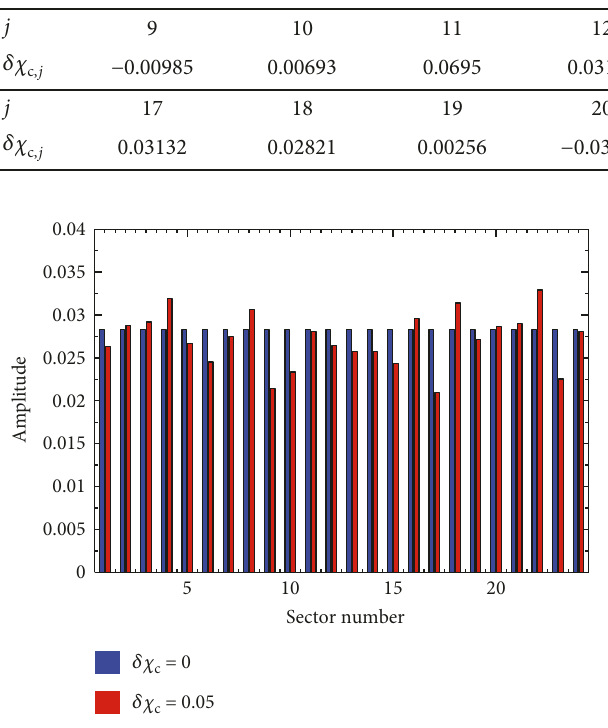
Figure 17: Response amplitude of di ff erent blades ( E = 2 ).